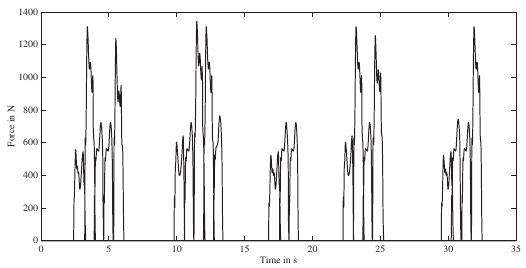
Figure 5. Walking forces created by the virtual walker after randomisation of timing and